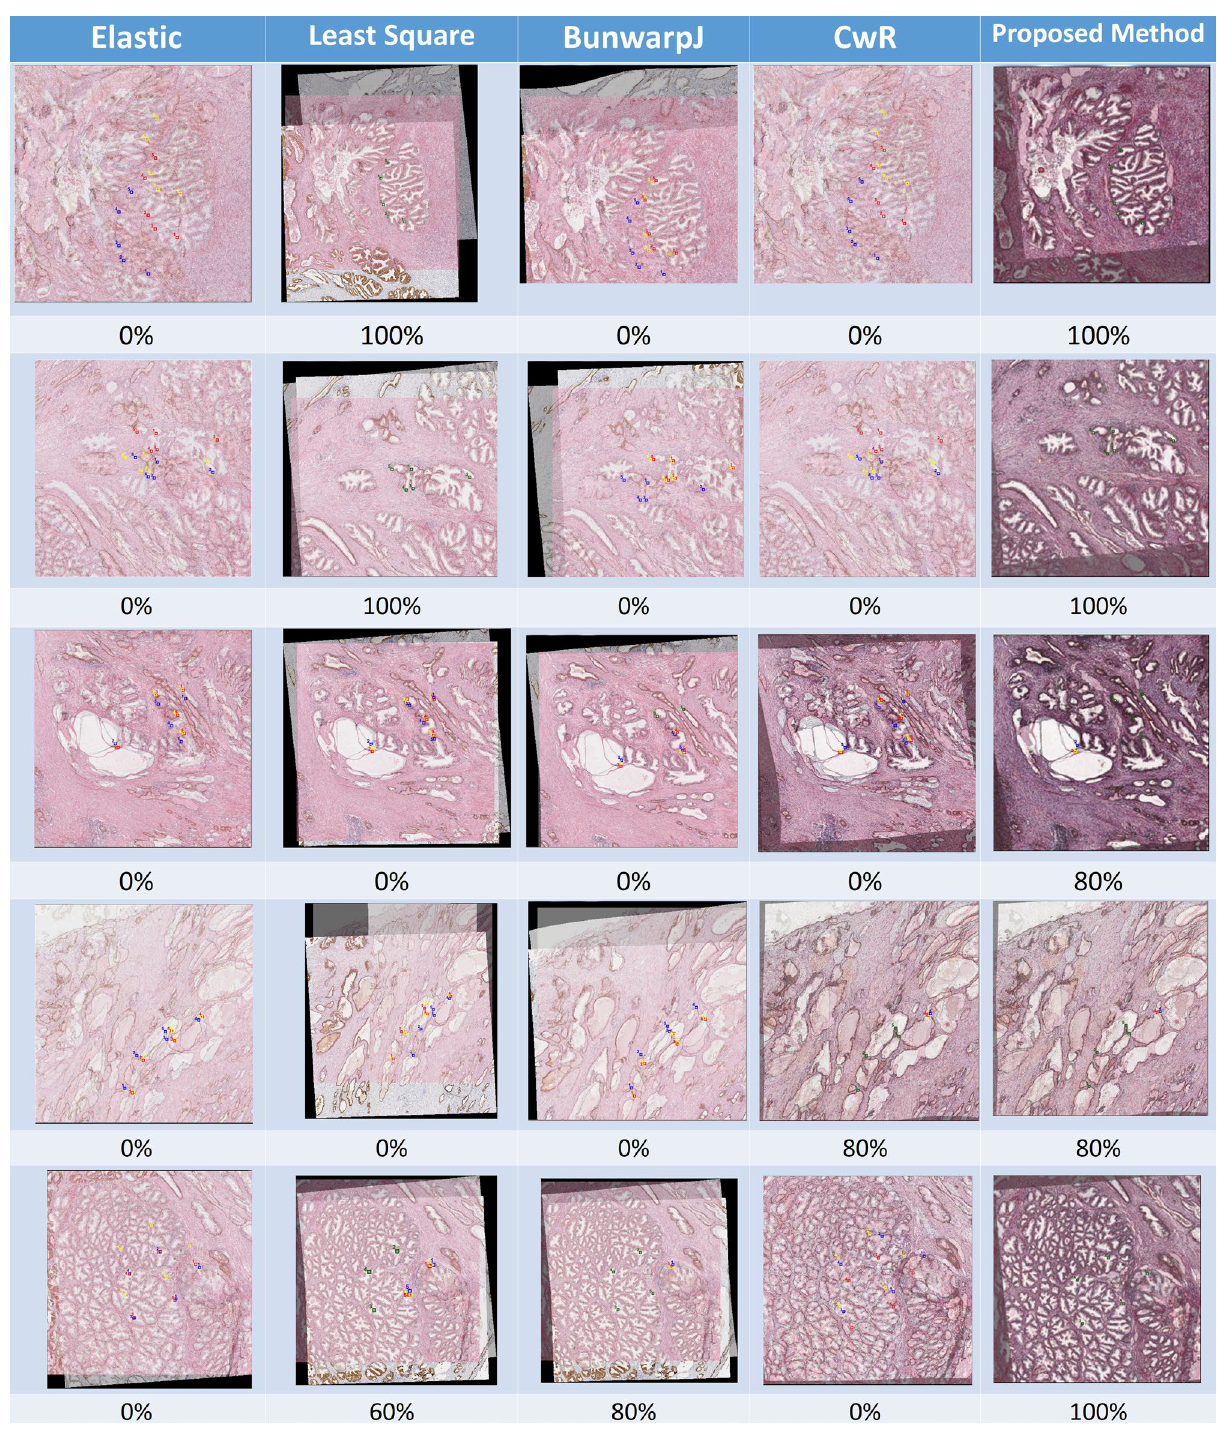
Figure 3. Registration results of the proposed method and benchmark approaches 7–10 in triple-staining prostate cancer samples. The blue rectangles represent the locations of the selected landmarks defined by experienced pathologists in the target image; the red boxes represent mismatches of corresponding landmarks in the transformed source image (IHC1); the yellow boxes represent mismatches of corresponding landmarks in the transformed source image (IHC2); the green boxes represent matches of corresponding landmarks in the transformed source